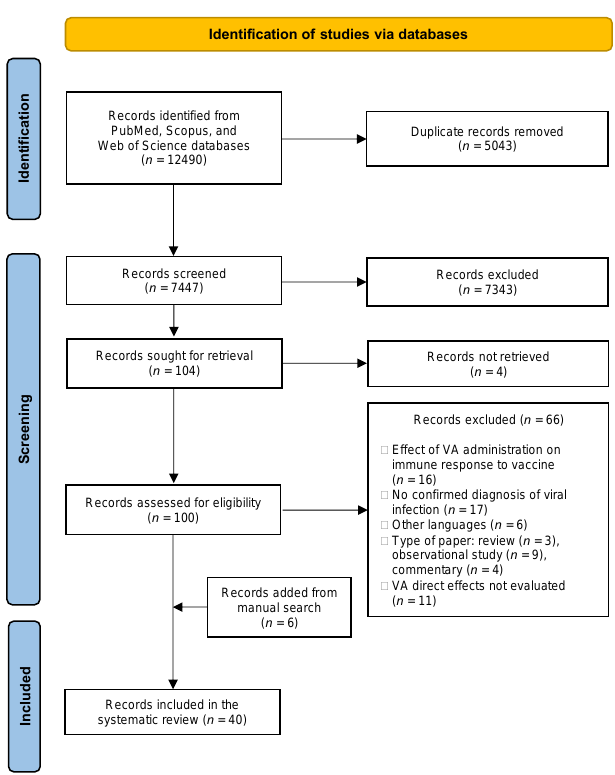
Figure 1. PRISMA flow diagram of the review process. VA: Vitamin A.